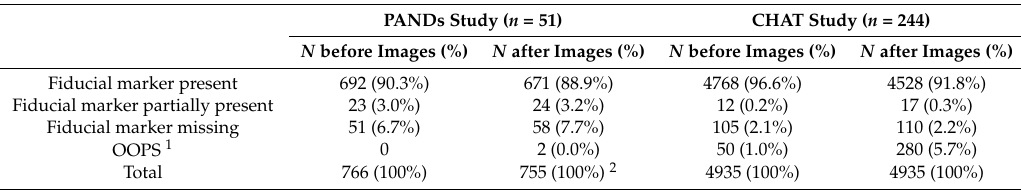
Table 2. Use of the mobile food record (mFR) app and inclusion of the fiducial marker in images taken by participants in the Physical Activity and Down syndrome (PANDs) and Connecting Health and Technology (CHAT)